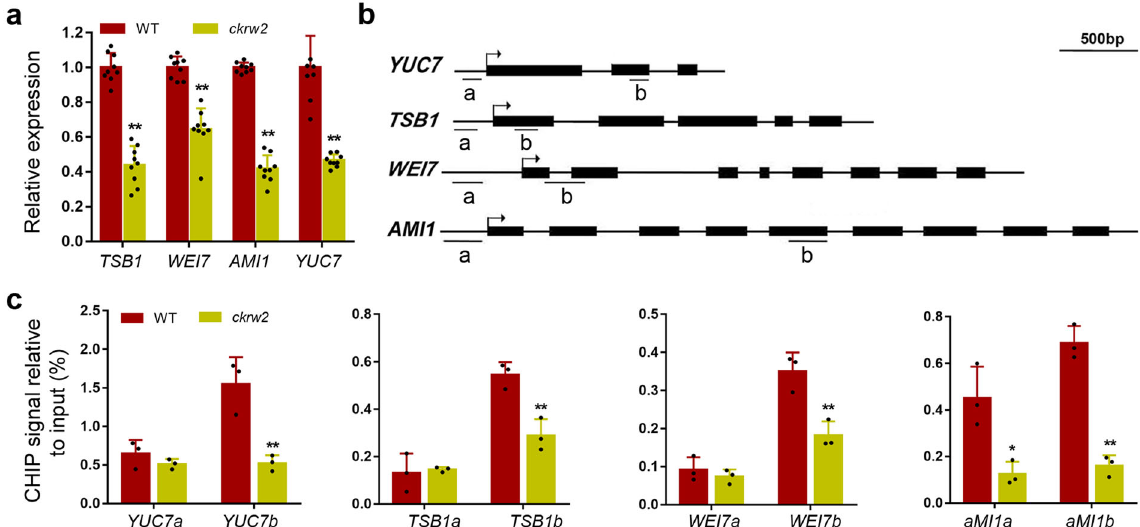
Fig. 3 Reduced expression of auxin synthesis genes in ckrw2 and analysis of H2Bub1 at these loci. a Relative transcription levels of TSB1 , WEI7 , AMI1 , and YUC7 genes in roots. ACTIN8 was used as an internal control. b Diagram representing the genomic structure and regions analyzed by ChIP assays, arrows indicate ATG start codon sites, and bars labeled “ a ” or “ b ” represent regions ampli fi ed by RT-qPCR in ChIP analysis. c H2Bub1 deposition at speci fi c loci. LCRa and FLCP4 were used as a negative and positive control, respectively (shown in Supplementary Fig. 7). Data are presented as mean ± SD, three independent biological experiments, the asterisk indicates a signi fi cant difference based on Student ’ s t test with ** P < 0.01, 0.01 < * P <